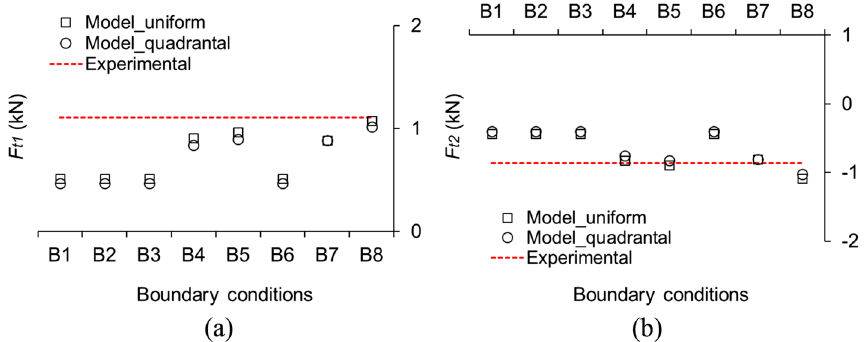
Fig. 8 Predicted member forces under various boundary conditions: a F t1 ; b F t2